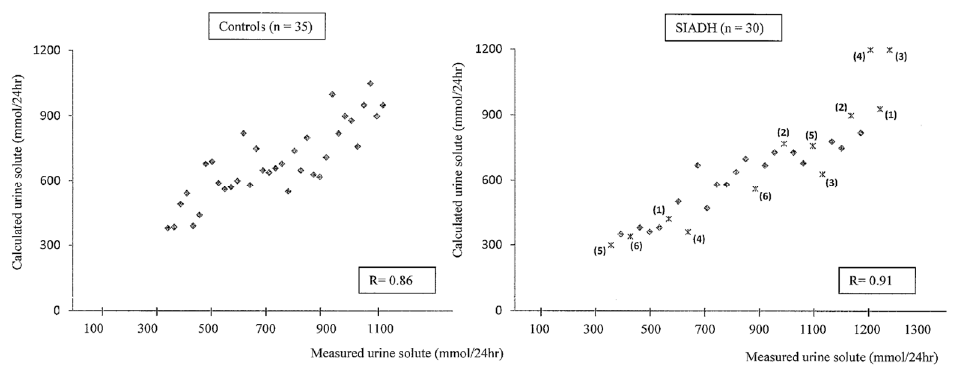
Figure 2. Correlation between the calculated urine solute output and the measured values in 35 controls and 30 patients with chronic hyponatremia due to SIADH. In six patients, represented by a number in brackets, the values are given before and after treatment with urea (see Table 3). Calculated urine solute (mmoL/24 h) was obtained by the formula using FE.Osm (see Table 1).